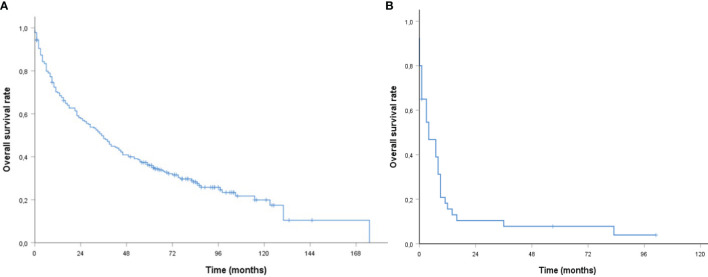
| Kaplan–Meier curves of older patients with head and neck cancer (A) curative (B) palliative (chemo) radiation with respect to overall survival.